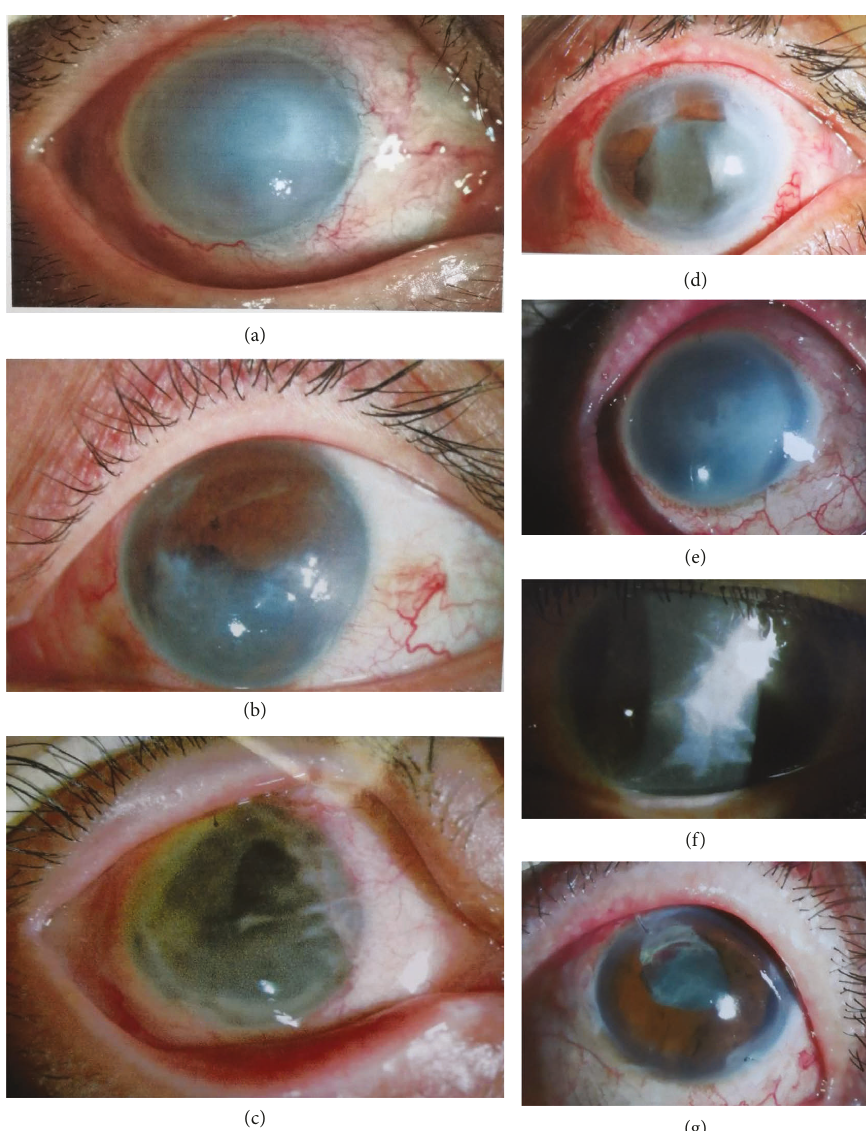
Figure 3: Anterior segment photography of the 7 cases at 6 months after FCVB